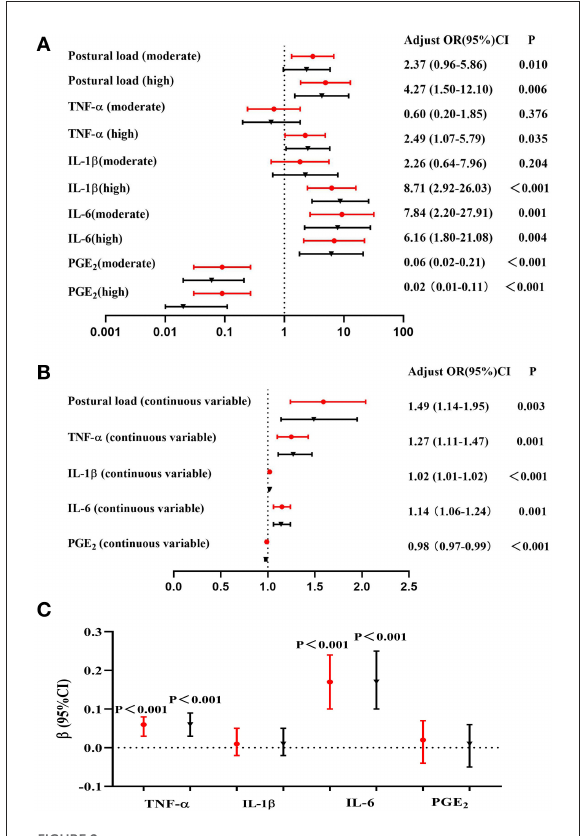
FIGURE2 Association among postural load, inflammatory cytokines, and lower back MSDs ( N = 132). (A) Association between postural load (categorical variable) and lower back MSDs, (B) Association between postural load (continuous variable) and lower back MSDs, (C) Association between postural load and inflammatory cytokines. The red circle indicates unadjusted models, and the black triangle indicates adjusted models (adjusted for gender, age, BMI, physical exercise time per week, hours spent per day working, hours spent per day working in a sitting position, hours spent per day using computers, and hours spent per day using